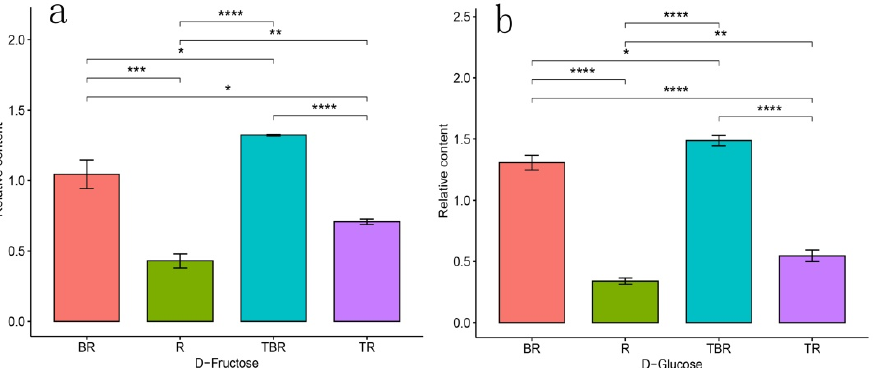
Figure 4. Effect of Trichoderma virens and Bacillus velezensis on the relative D-fructose and D-glucose content of tomato plants. The treatments were as follows: R = Ralstonia solanacearum (RS-15); TR = Trichoderma virens (Tvien6) + RS-15; BR = Bacillus velezensis (X5) + RS-15; and TBR = Tvien6 + X5 + RS-15. The relative D-fructose ( a ) and D-glucose ( b ) content are shown as the mean of six replications ± standard deviation (SD). * Represents significance; * represents that the p value is less than 0.05; ** represents that the p value is less than 0.01; *** represents that the p value is less than 0.001; and **** represents that the p value is less than 0.0001.